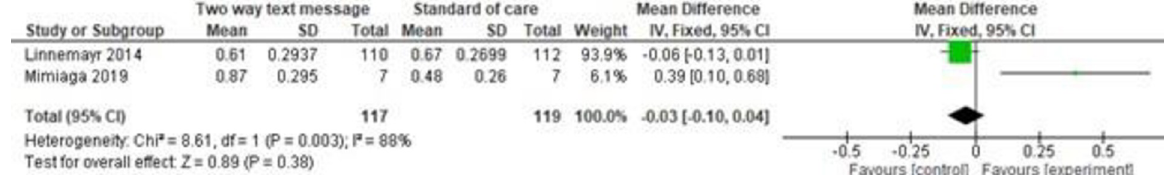
PLOS ONE | https://doi.org/10.1371/journal.pone.0254890 July 22,